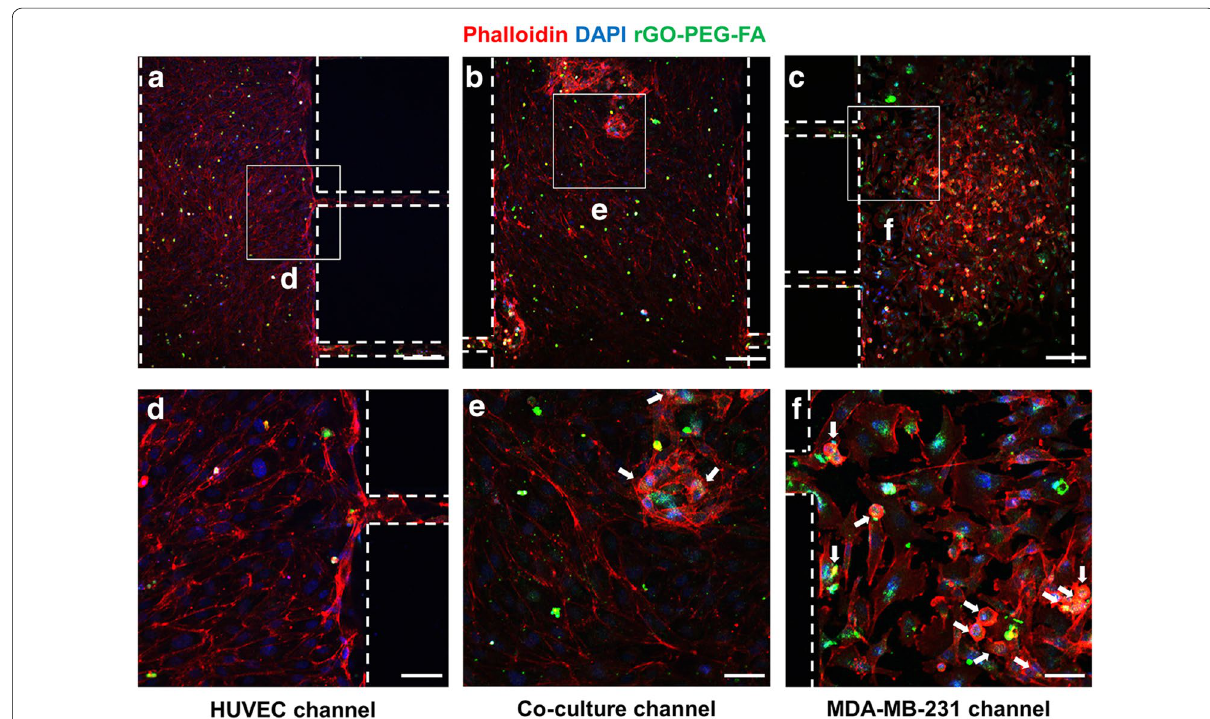
Fig. 6 Confocal laser scanning microscopy images of cellular uptake after treatment with 30 μg/mL of rGO‑PEG‑FA nanomaterials in a microfluidic co‑culture platform. Images of the HUVEC ( a ), Co‑culture ( b ), and MDA‑MB‑231 ( c ) channel. High magnification images ( d – f ). White arrows indicate nanomaterial uptake in cells. Scale bars are 100